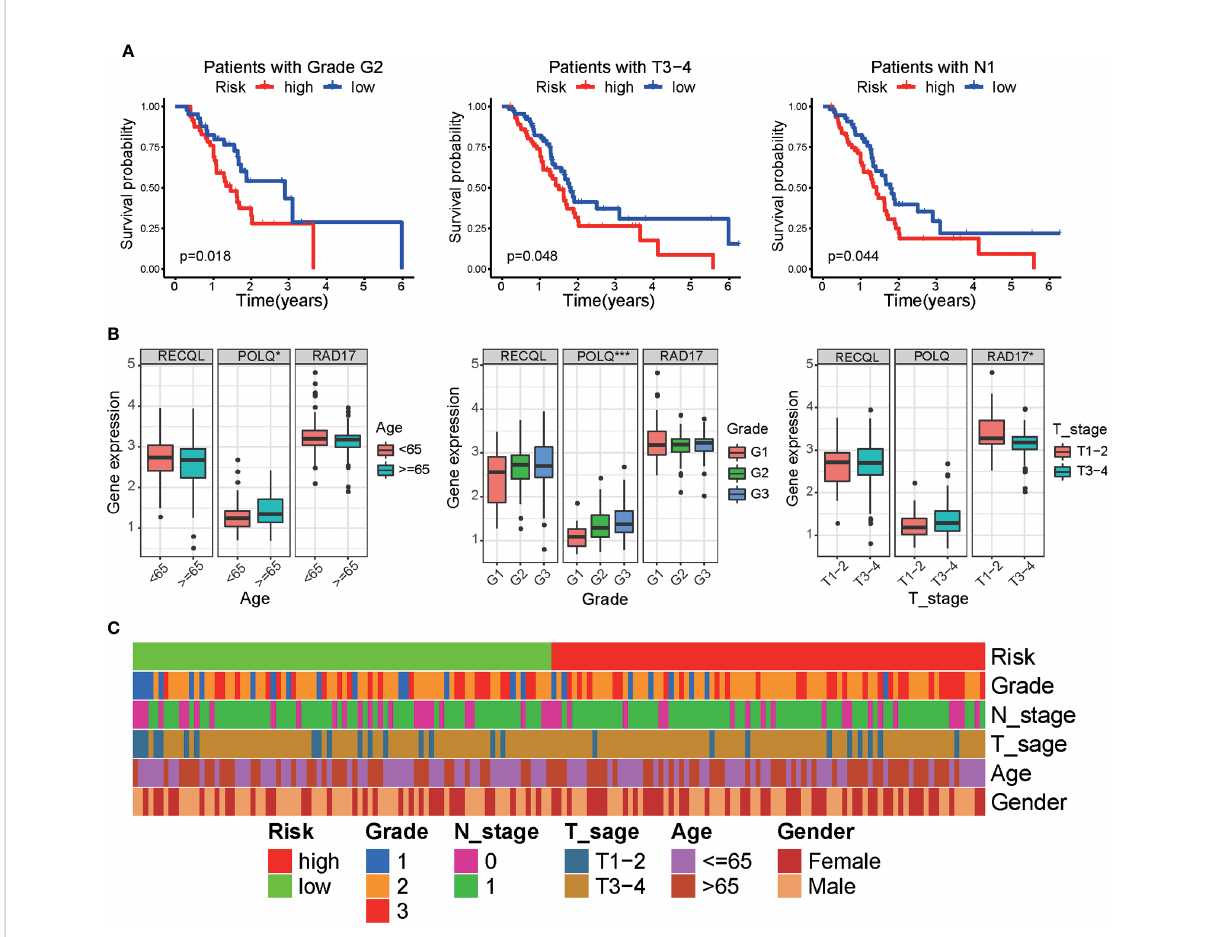
FIGURE 5 Correlation between clinical parameters and the DRG signature. (A) Kaplan − Meier survival analysis of the overall survival of patients between the prognostic signature and different clinical subgroups. (B) Boxplot showing the correlation between three DRGs and clinical characteristics in PAAD patients. (C) Heatmap showing the associations between risk score and clinicopathological characteristics. *p < 0.05, ***p <